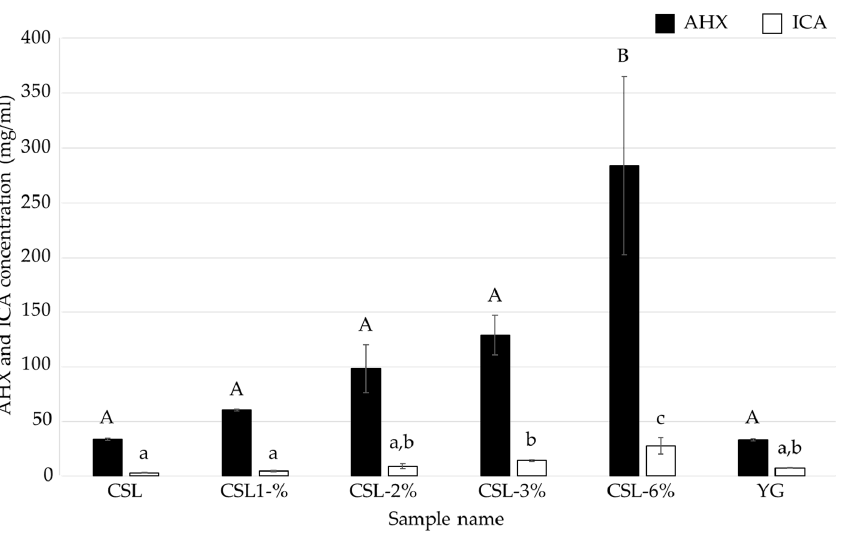
Figure 4. AHX and ICA contents of the culture filtrates of L. sordida mycelia cultured in media con- taining various concentrations of CSL. Different alphabet letters (capital letters for AHX, and small letters for ICA) indicate significant differences (Tukey–Kramer post hoc test, p < 0.05; n = 3).